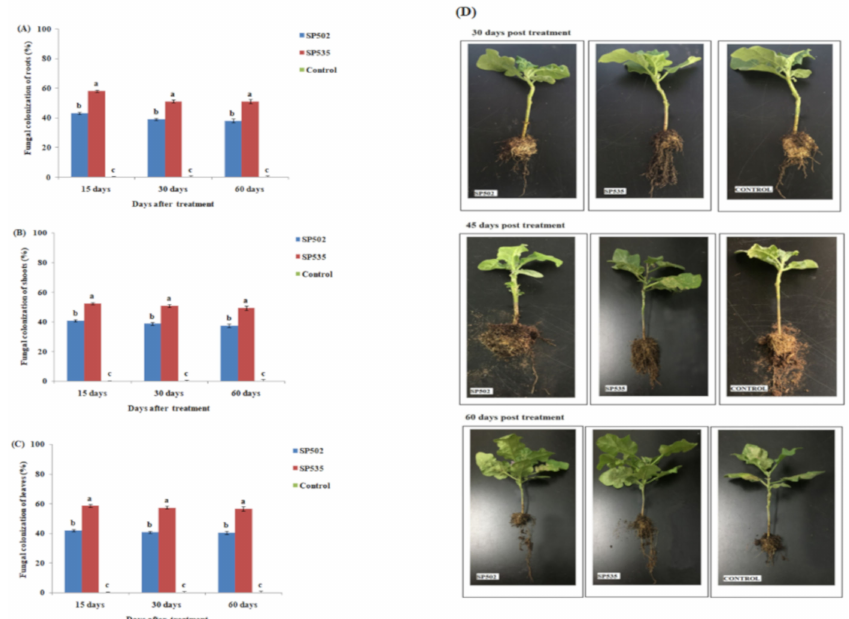
Figure 2. E ff ect of Cordyceps fumosorosea isolates on growth parameters of eggplant after 30, 45, and 60 days of fungal treatment. ( A ) Root length; ( B ) shoot length; and ( C , D ) number of leaves. Error bars indicate the standard error of means based on five replicates (n = 5). Bars having di ff erent letters indicate that means are significantly di ff erent from each other at 5% level of significance.